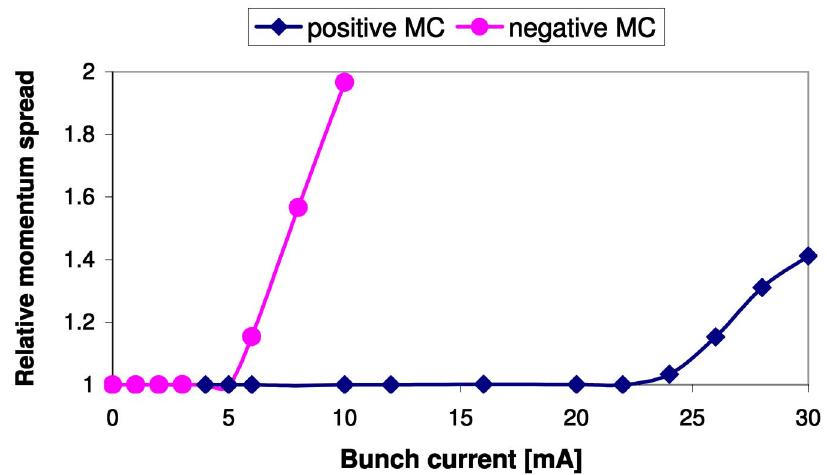
FIG. 6. (Color) Energy spread vs beam current for positive and negative momentum compaction